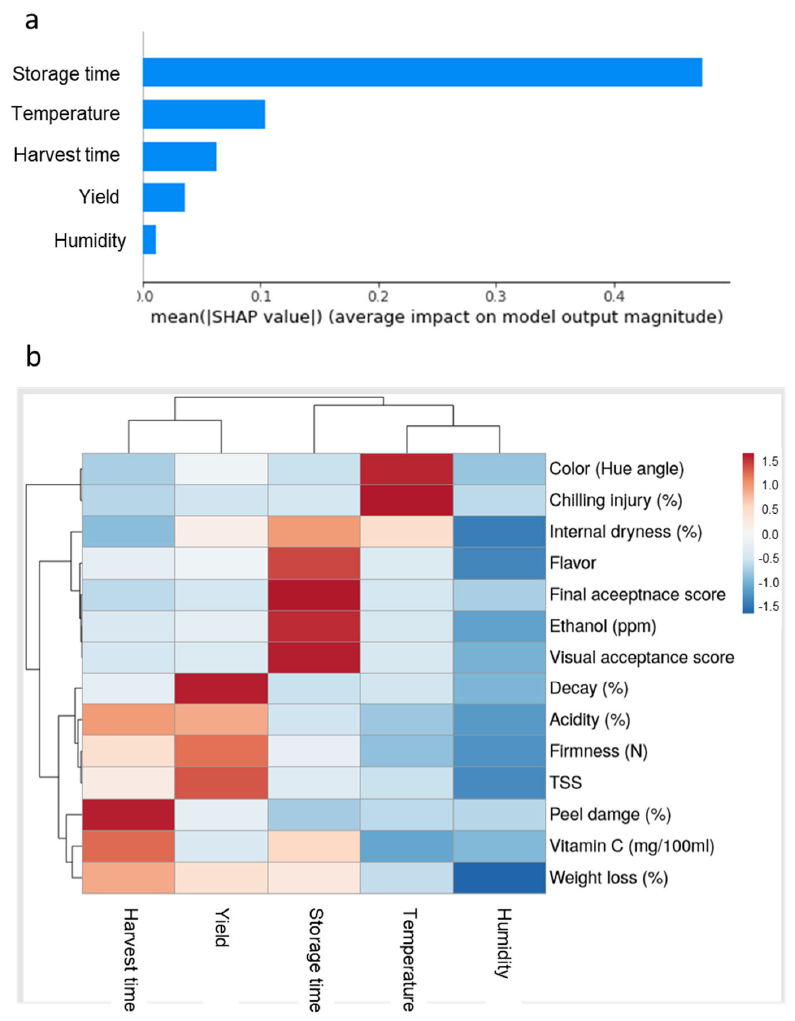
Figure 5. Importance of the various pre-harvest and postharvest features on the quality of ‘Rustenburg’ navel oranges. ( a ) Feature importance analysis using the SHAP method. ( b ) Feature importance and heat ‐ map analyses using the RF MDA method.